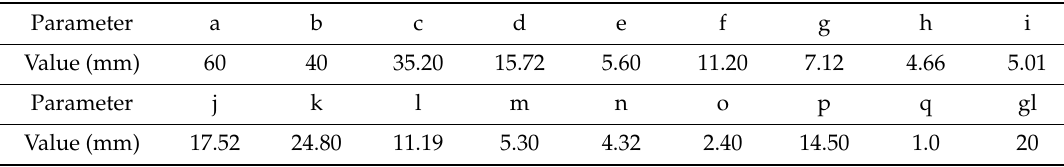
Table 1. The dimensions of proposed retro VMA.